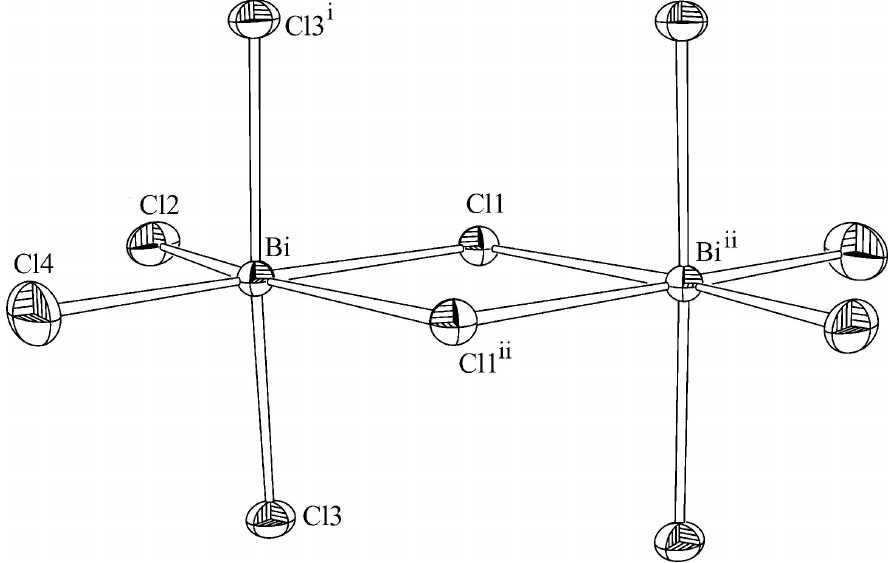
Figure 1 A view of the dinuclear [Bi